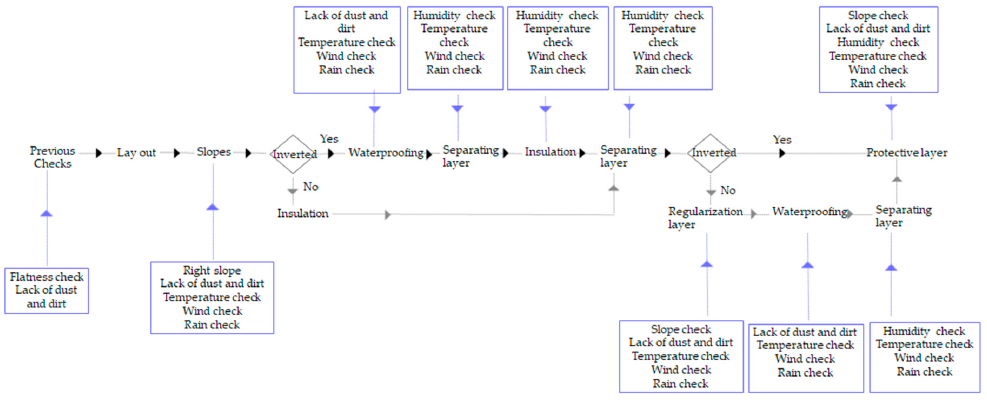
Figure 4. Variables that cause most of the defects in walkable flat roofs.